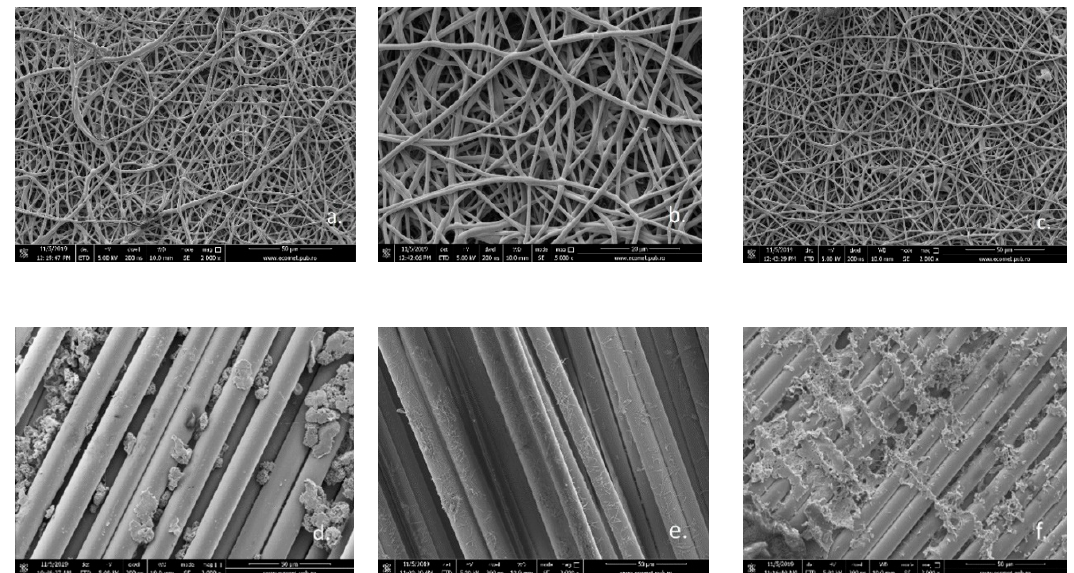
Figure 6. SEM images for fiberglass covered with PLA/TiO 2 hybrid nanofibers: ( a ) fabric plain